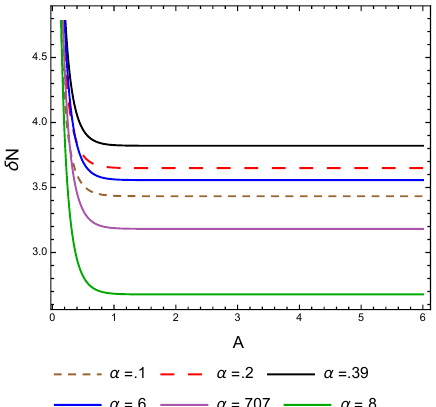
plot for different a A